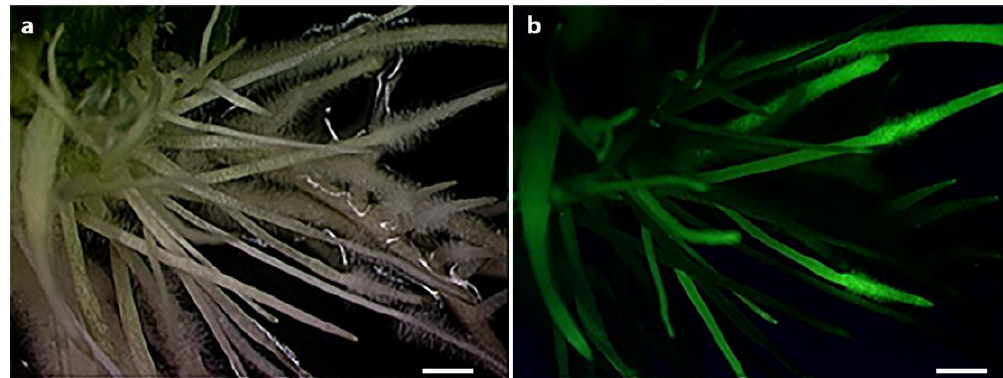
Figure 4. The typical expression of soybean hairy roots transformed with pUFamiR constructs containing GFP reporter. The observation of transgenic roots after 3 weeks grown on selection medium. ( a ) The positive root structure was observed under bright field; ( b ) The positive root structure was observed under blue light. Scale bar stands for 1 mm.